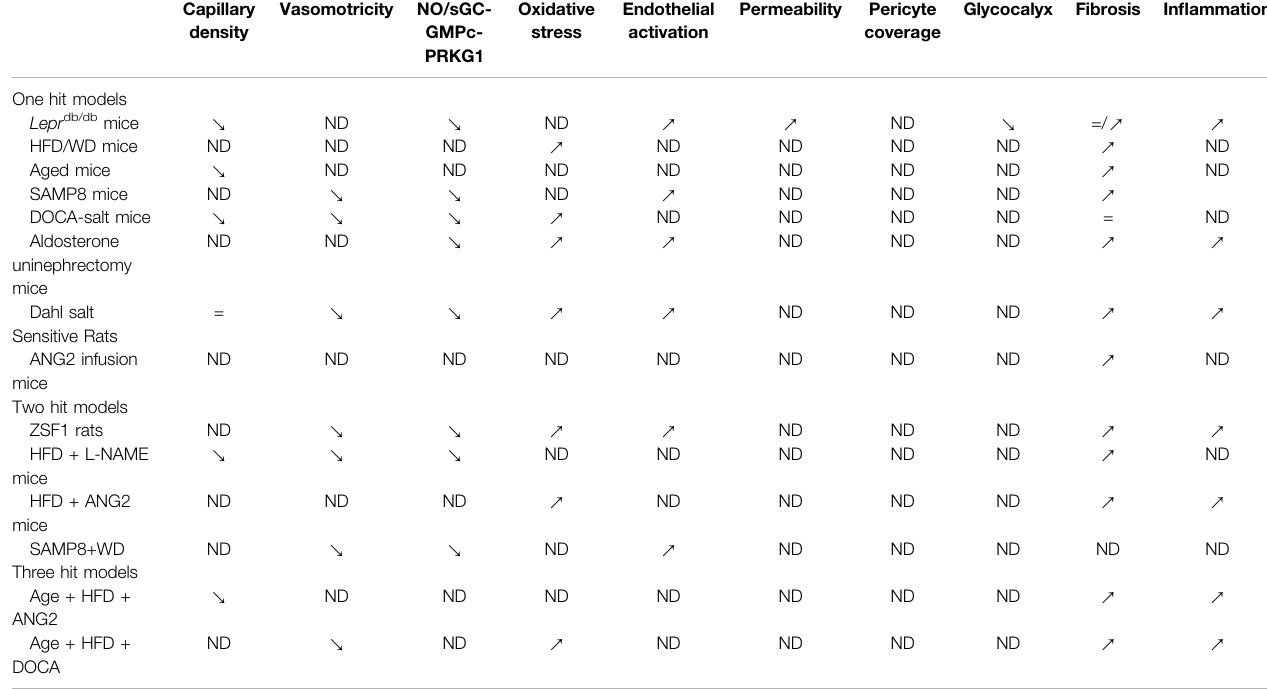
TABLE 3 | Microvascular characteristics of rodent models of HFpEF.